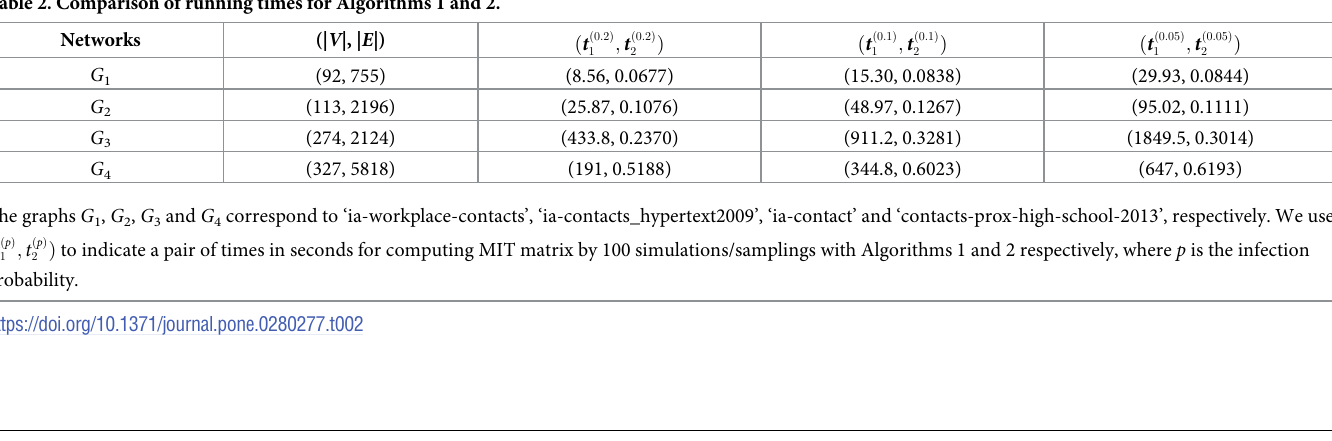
Table 2. Comparison of running times for Algorithms 1 and 2. Networks